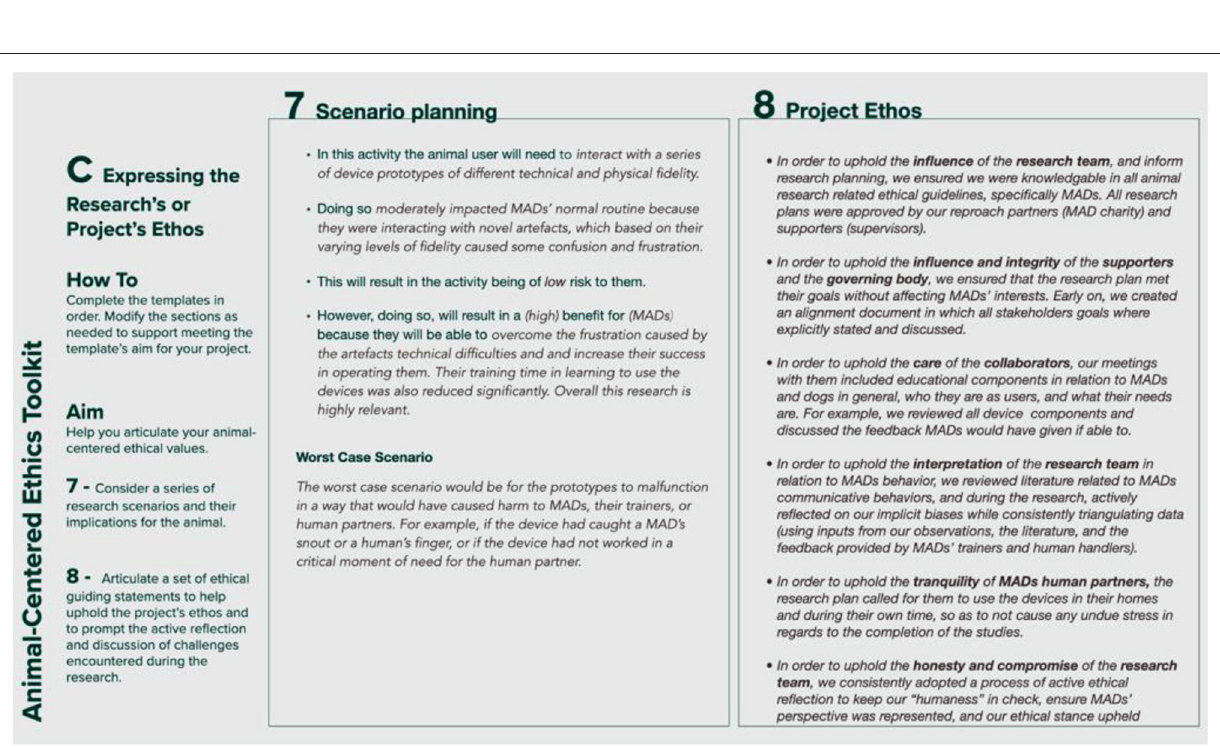
Frontiers in Veterinary Science |